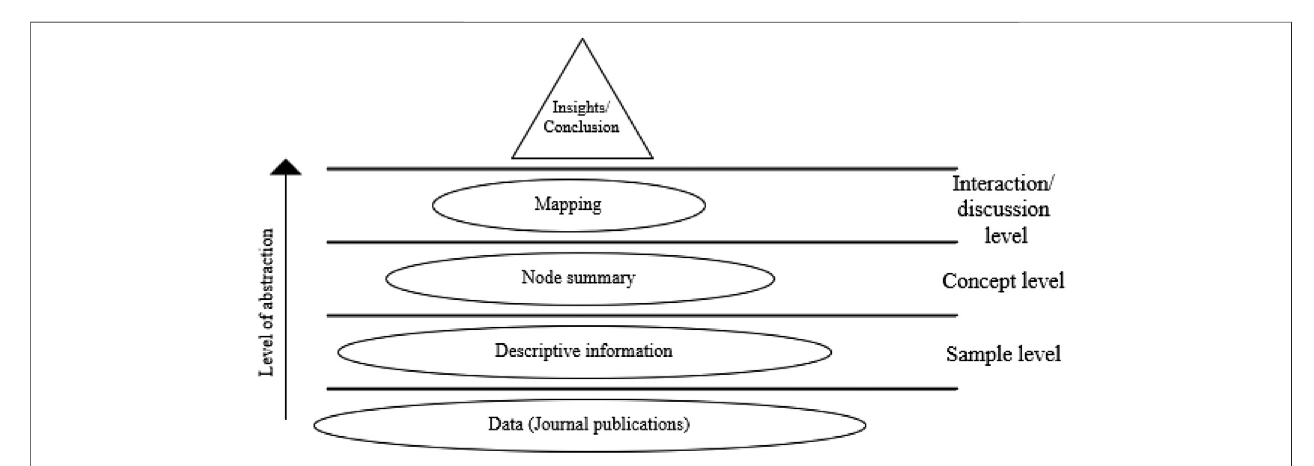
FIGURE 4 | Analysis